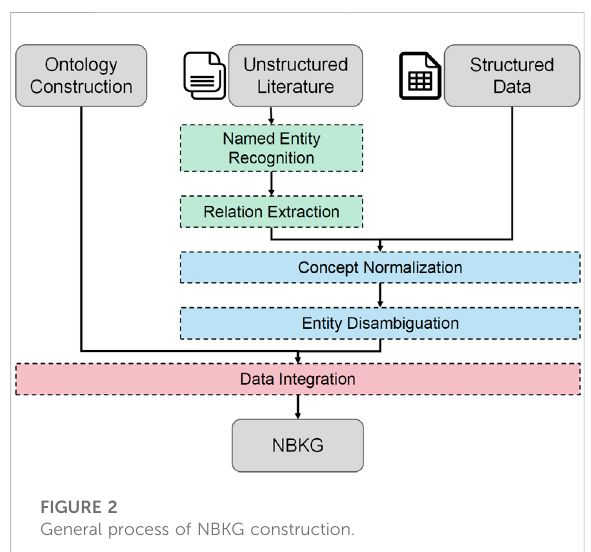
FIGURE 2 General process of NBKG